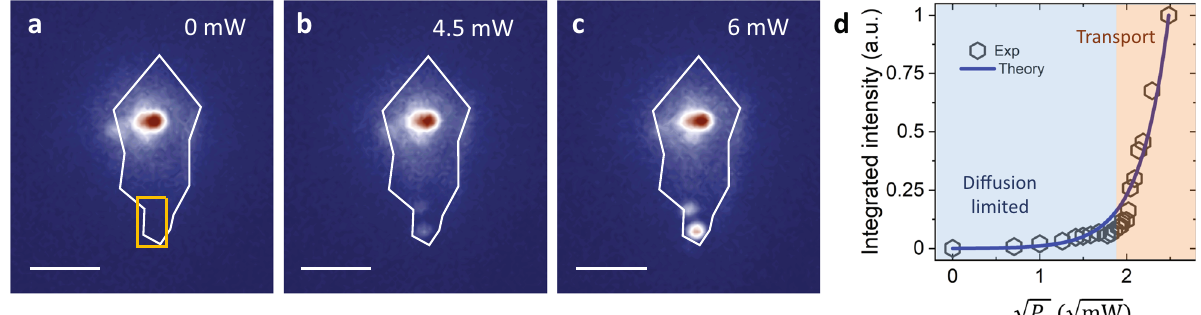
Fig. 3 Acoustic power-dependent IX transport at 100 K. PL images at different SAW power P s of ( a ) 0 mW, ( b ) 4.5 mW, ( c ) 6 mW. The solid white line outlines the WSe 2 fl ake. The two bright emission spots at the edge of the WSe 2 fl ake highlight the SAW-driven transport of IXs. Scale bar, 10 µ m. d The integrated emission intensity at the fl ake edge (in the area indicated by the yellow box) in a depending on the SAW power P s . The experimental data is fi tted with the theoretical model that the transport exciton density exponentially depends on the square root of P diffusion-limited (blue shaded). A high P s , SAW-driven transport is activated (red